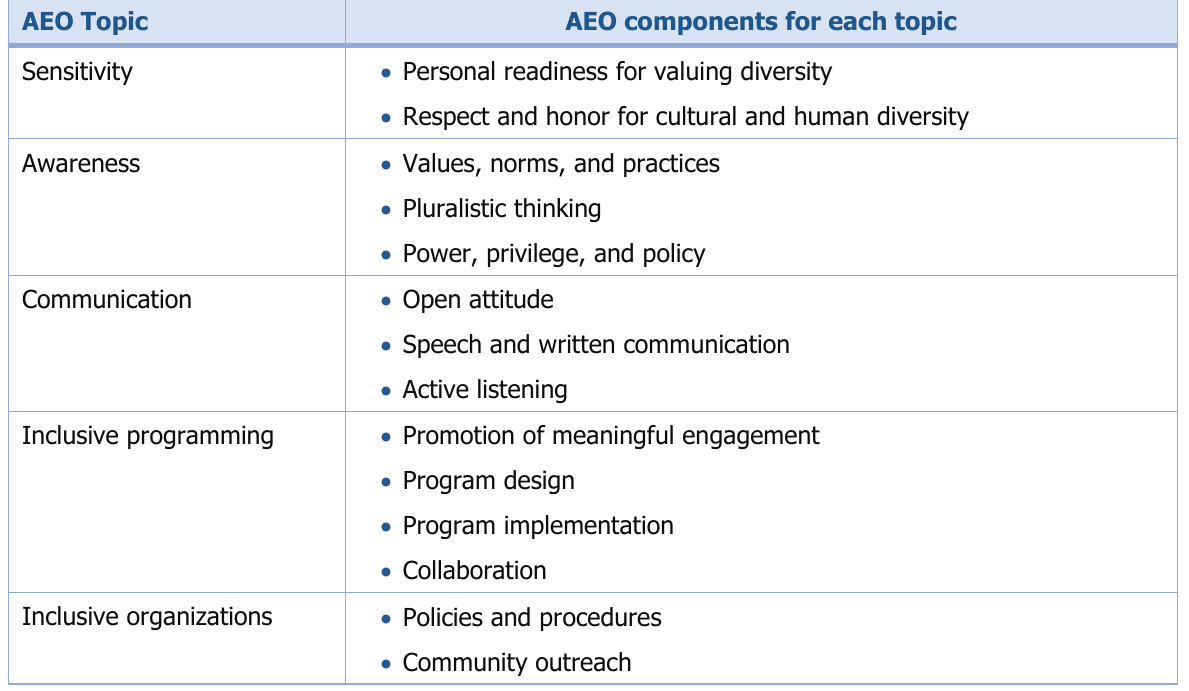
Table 1. AEO Topics and Components AEO Topic AEO components for each topic